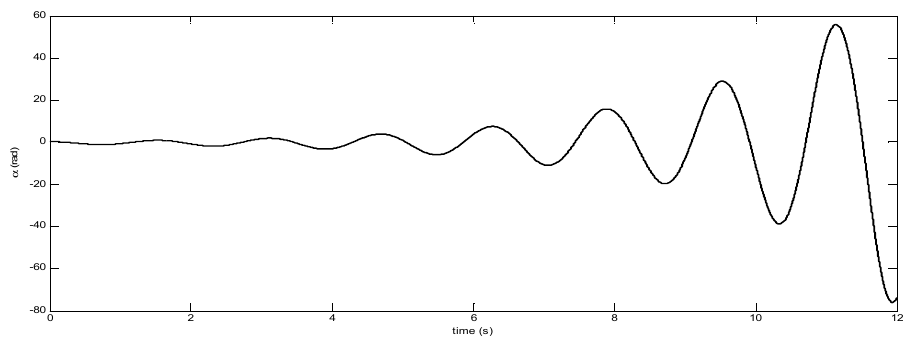
Figure 20. Time response of alpha in upper speed of flutter (35 m/s).